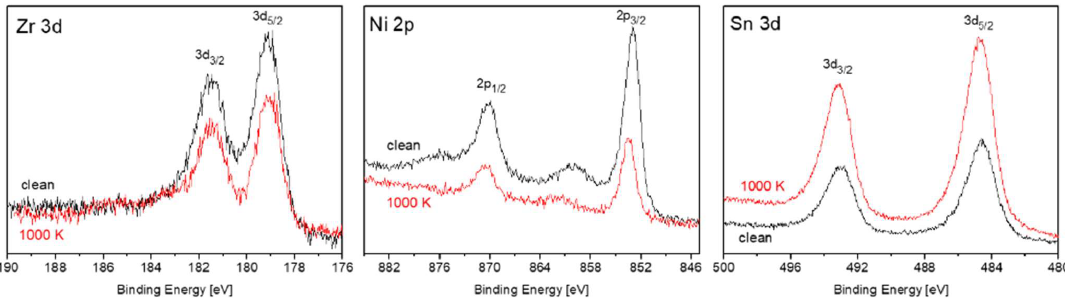
Figure 4. Zr, Ni and Sn spectra, taken from the ZrNiSn alloy before (black) and after (red) heating to 1000K.